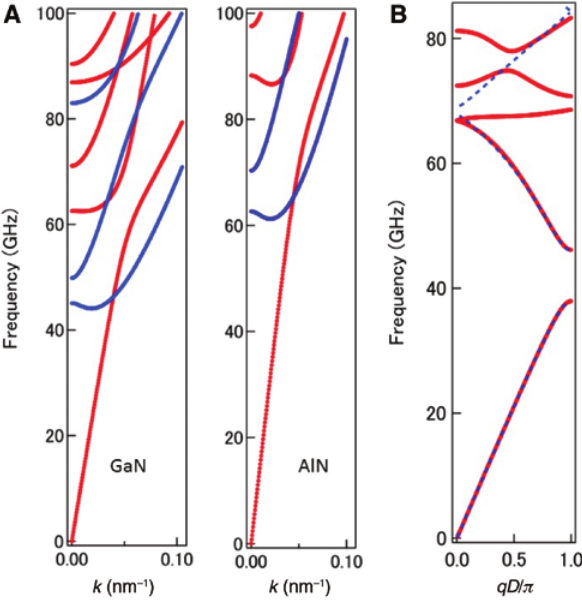
Figure 15: (A) Phonon dispersion relations of a 75 nm diameter GaN and AlN nanowires. (B) Dispersion relations of an AlN/GaN nanowire superlattice with a 56 nm GaN thickness and 42 nm AlN thickness. Reproduced from [36]. Copyright 2018 The Japan Society of Applied